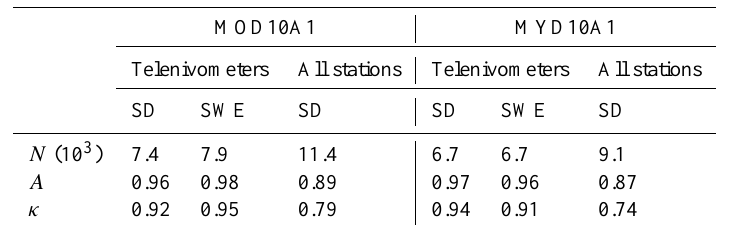
Table 3. Statistical measures of the comparison between the MODIS product and in situ data, computed from the results presented in Table 2 ( N : sample size, A : overall accuracy, κ : kappa coefficient).